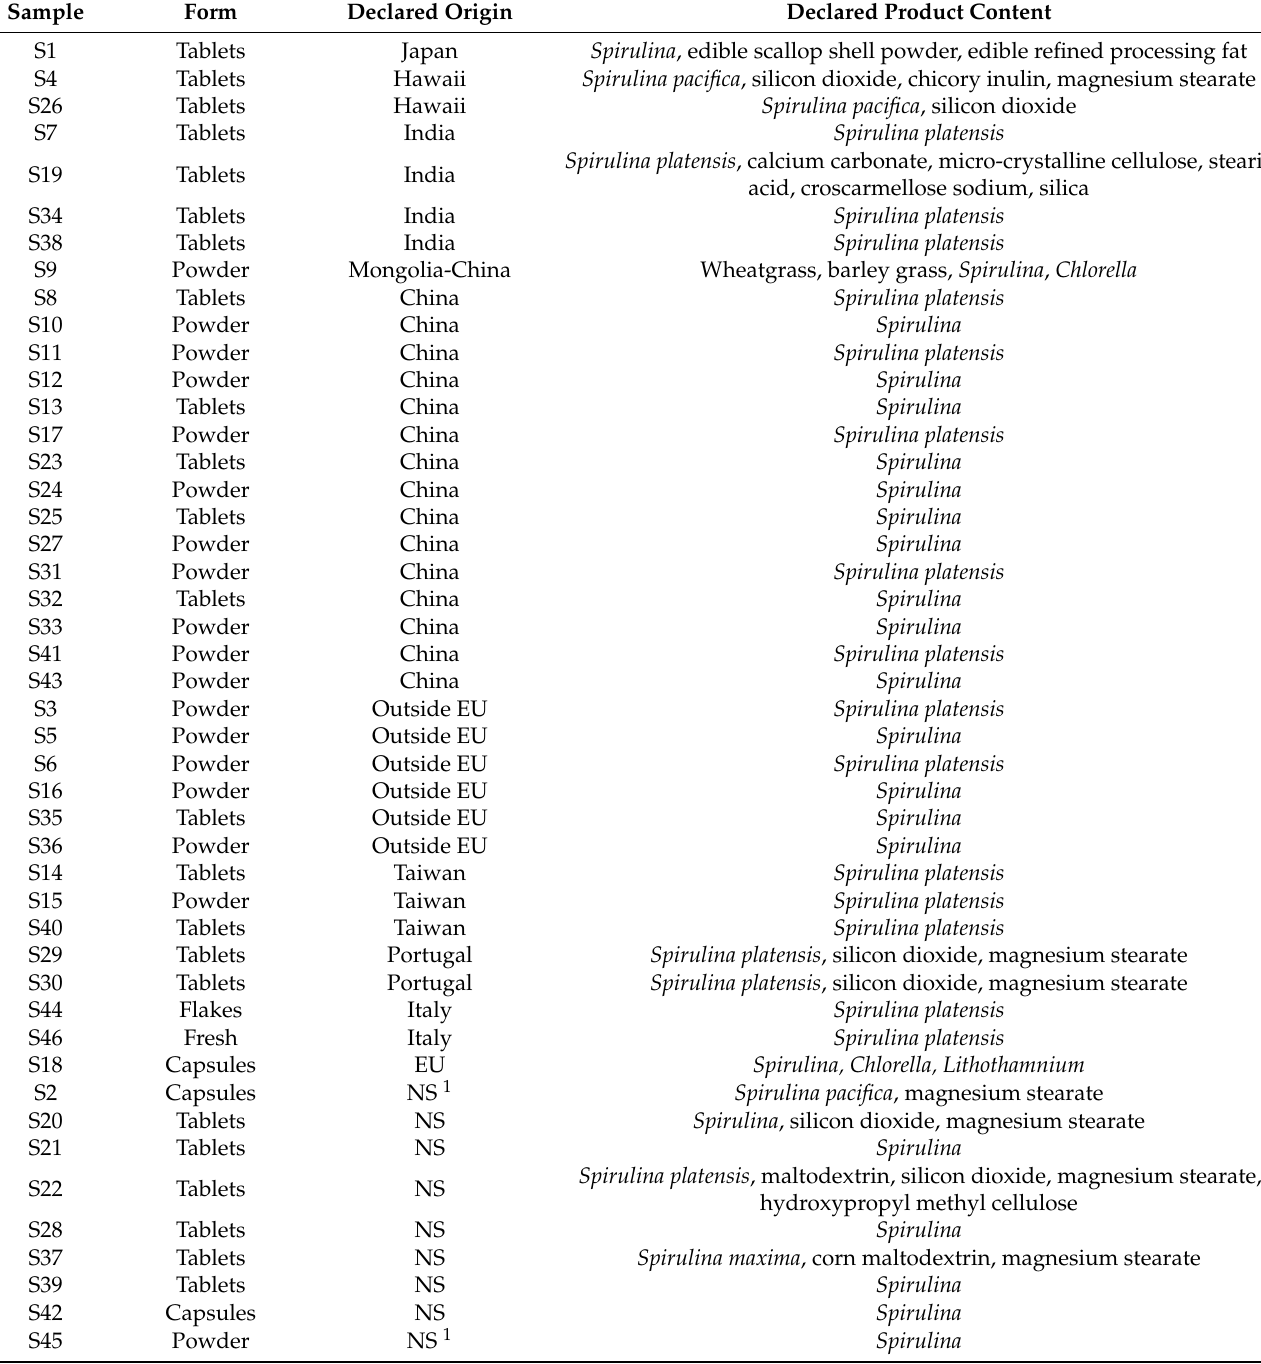
Table 1. List of Spirulina supplements purchased from the Slovenian market, including their origin, product content and form as declared on the product label. The samples are clustered according to the declared country of